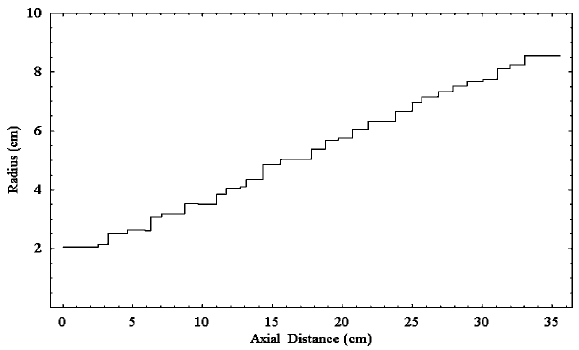
FIG. 5. Input taper designs produced by the mode matching optimization code.